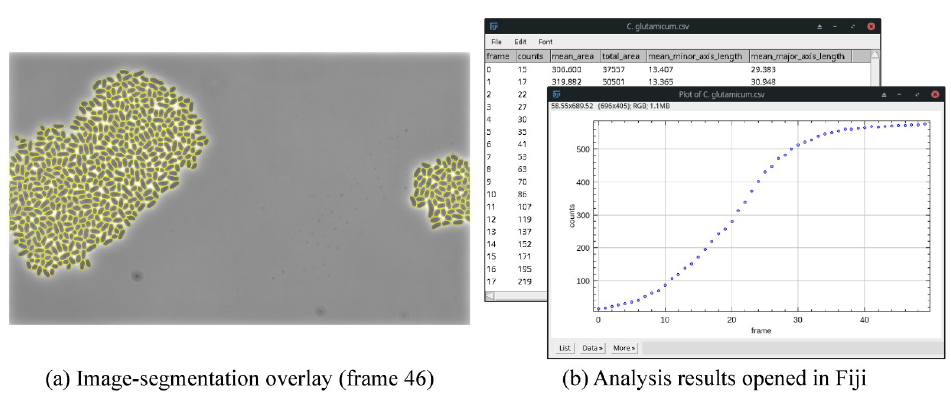
Fig 7. Exemplary microbeSEG segmentation (a) and analysis results (b) for a growing C. glutamicum colony. The results can easily be viewed in Fiji. S1 Video shows a video of the segmentation results of the growing colony.